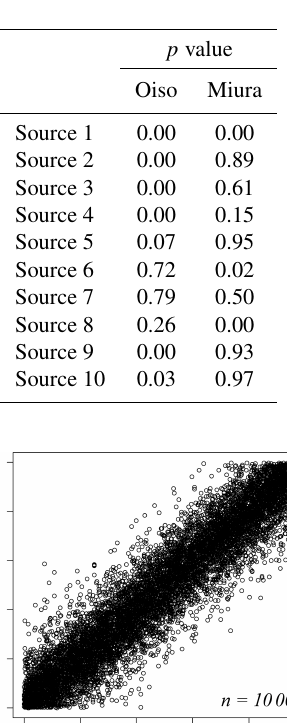
Table 5. Kolmogorov–Smirnov test results.